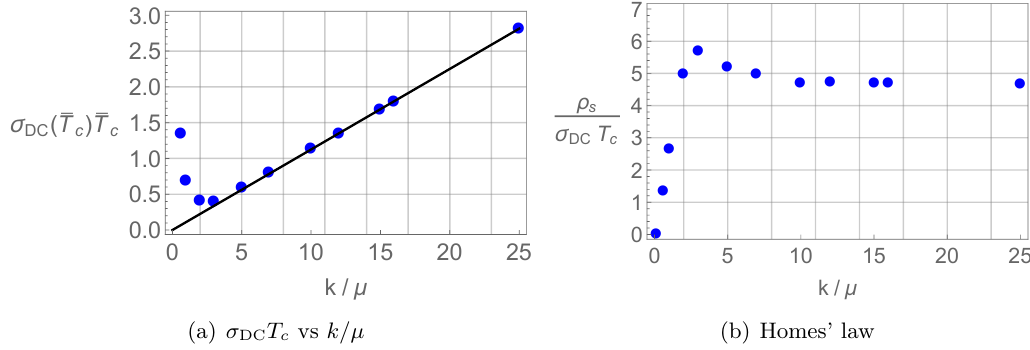
Figure 7 . Left: σ DC T c vs k . ¯ T c is the shorthand notation for T c /µ . The black solid line is (3.13). Right: checking Homes’ law: Homes’ law appears to hold in the strong momentum relaxation